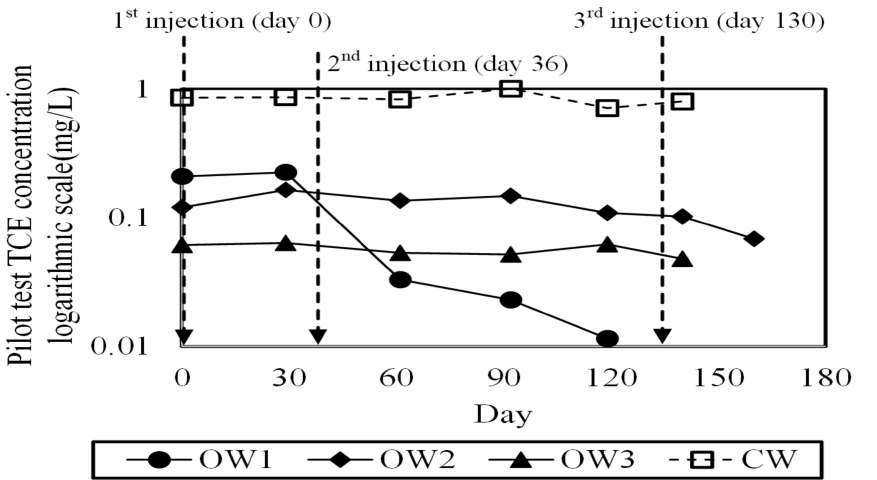
Figure 7. TCE concentration variation of each monitoring well in the in situ field